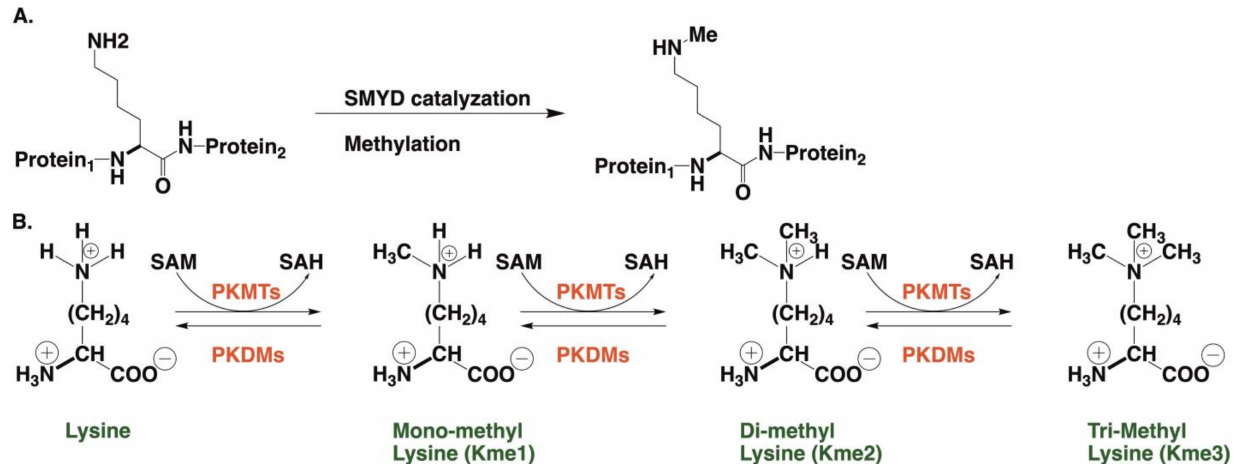
Figure 1. Representations of the five SMYD proteins where the SET domain is split by the MYND domain. Adopted with permission from Ref.